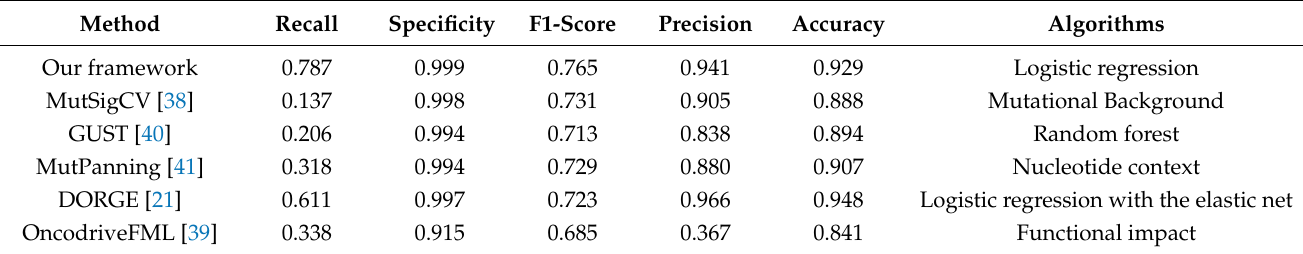
Table 1. Results of cancer gene identification.